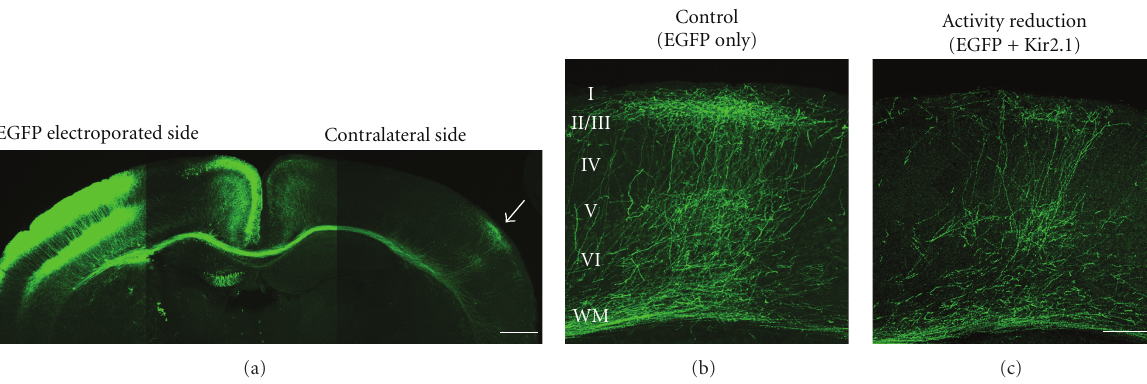
Figure 1: Visualization of callosal axon projections and an e ff ect of activity reduction. (a) An in utero electroporation-mediated gene transfer method [38] was used to unilaterally express EGFP in layer 2/3 cortical neurons (electroporated side). EGFP-labeled callosal axons extend through the corpus callosum, and project densely to a narrowly restricted region in the contralateral cortex (arrow). Scale bar, 500 μ m. (b) EGFP-labeled control callosal axons show lamina specific projection pattern. (c) Reduction of neuronal activity in callosal projection neurons disturbs their axonal projections. Adapted from [38]. Scale bar, 200 μ